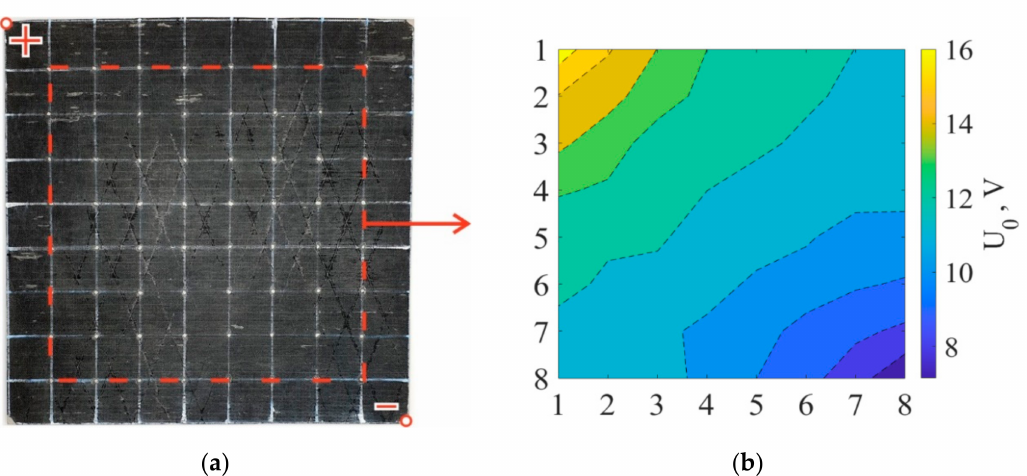
Figure 9. GFRP/MWCNT [0 ◦ , 90 ◦ ] 4 undamaged composite plate ( a ) and experimentally obtained voltage distribution ( b ). Vertical and horizontal numbers from 1 to 8 define the coordinates of electrodes on the composite plate.